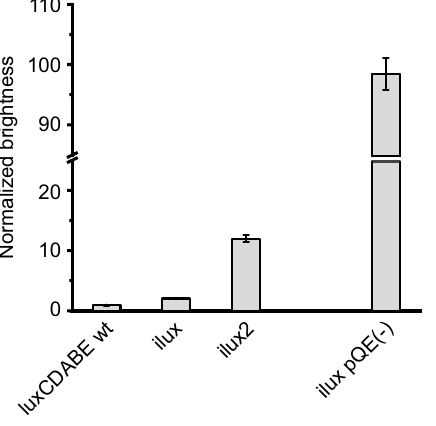
Figure 6. Comparison of bioluminescence emission from the chromosomally expressed operons luxCDABE wt , ilux and ilux2 (left) with ilux expressed from the vector pQE(−) (right) in Top10 cells. The bioluminescence signal was normalized to the luxCDABE wt strain. Error bars represent SD of 10 different